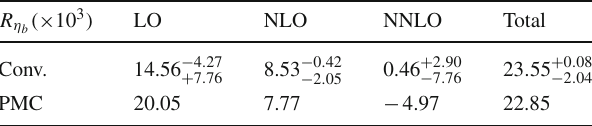
Table 3 Contributions from each loop term for R η NNLO level (in unit: × 10 3 ) under conventional and PMC scale-setting approaches. The central values are for μ r = 2 m b , and the errors are for